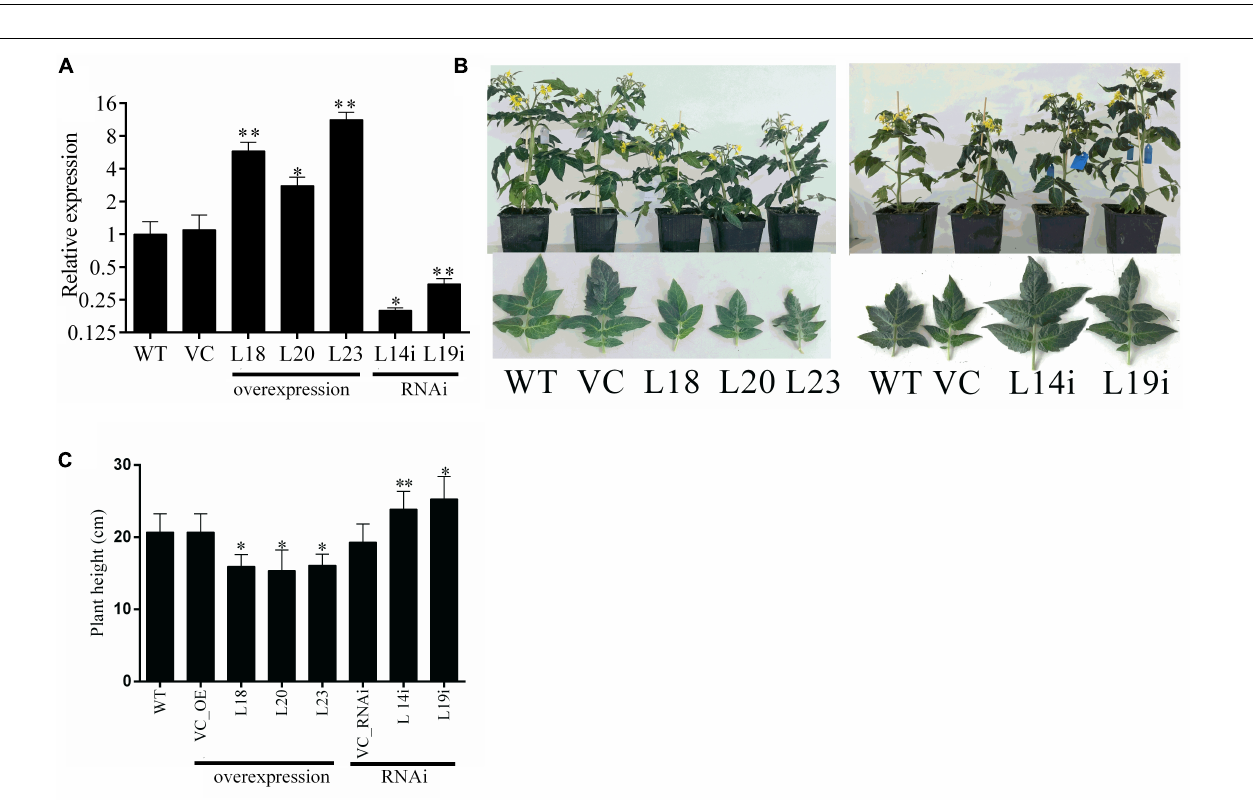
FIGURE 3 | Transgenic line generation and phenotypic characterization of WT, empty vector, and transgenic plants. (A) Expression levels of SlbHLH22 in WT, empty vector (VC), and transgenic lines (L18, L20, L23) overexpressing and RNAi-silencing (L14i and L19i) of SlbHLH22 in leaves. Dunnett’s tests was used in the comparison between WT, VC, and SlbHLH22 overexpression lines (L18, L20, L23) (B) 6-week-old WT, VC, and three independent transgenic lines (L18, L20, L23, L14i, and L19i) plants. Phenotype of fifth leaves in WT, empty vector (VC) plants, and in SlbHLH22 transgenic line plants (C) Height of plants WT, VC, and transgenic lines. Data represent mean of ± SE for three independent biological replicates ( n = 3) and each replicate contained 15 plants. ∗ and ∗∗ represent the significant difference as determined by t -test ( P -value ≤ 0.01 ∗∗ /0.05 ∗ ).